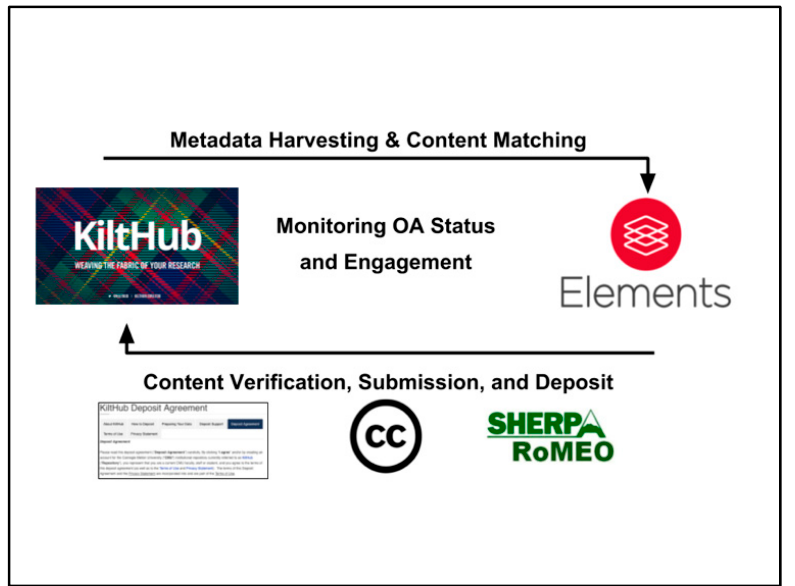
Figure 2. The Institutional Repository (IR)-Research Information Management (RIM) System Integration at Carnegie Mellon University (CMU).